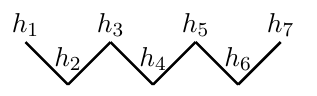
Figure 19 . The state j h 1 h 2 h 3 h 4 h 5 h 6 h 7 i